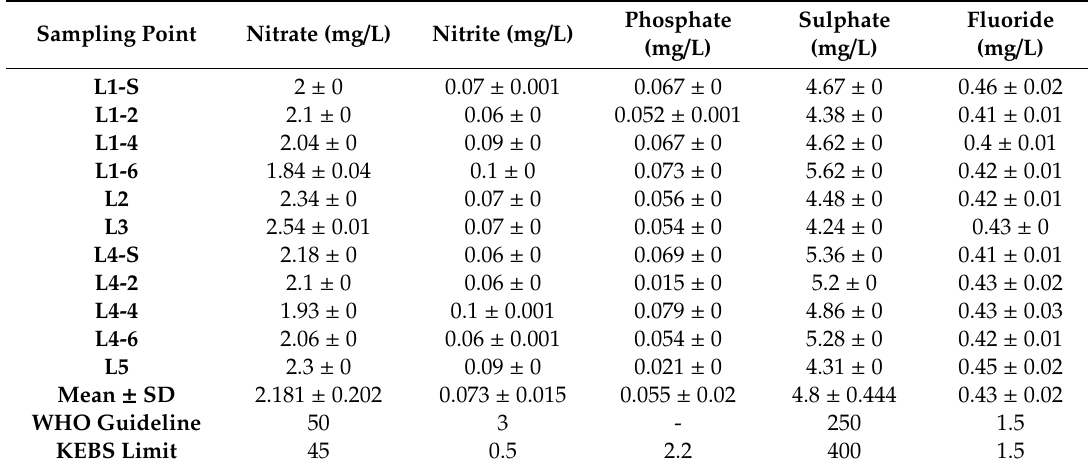
Table 10. Concentration of chemical parameters in Rungiri quarry reservoir in August 2019.